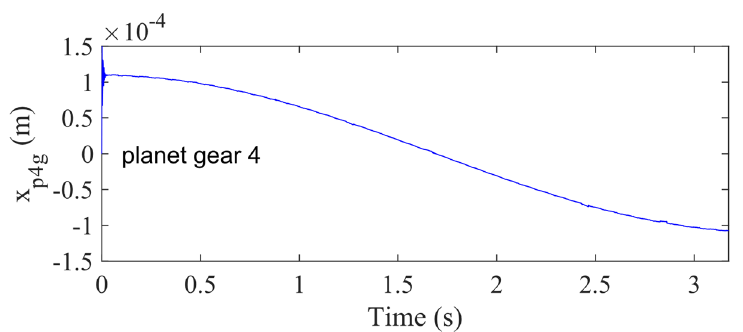
Figure 14. Vibration response in x g -direction for the fourth planet gear with 50% sun gear crack level for Case 4.